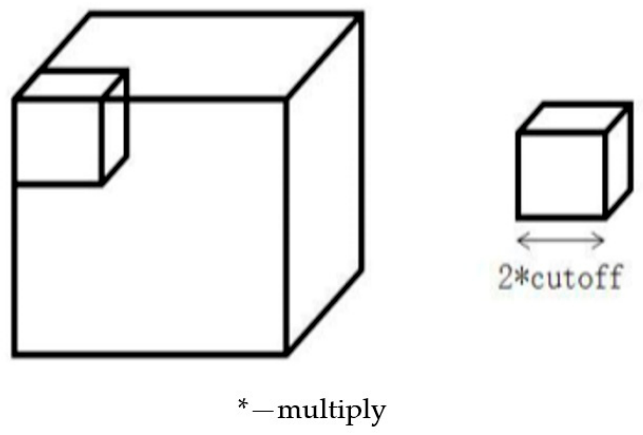
Figure 5. Schematic diagram of cell